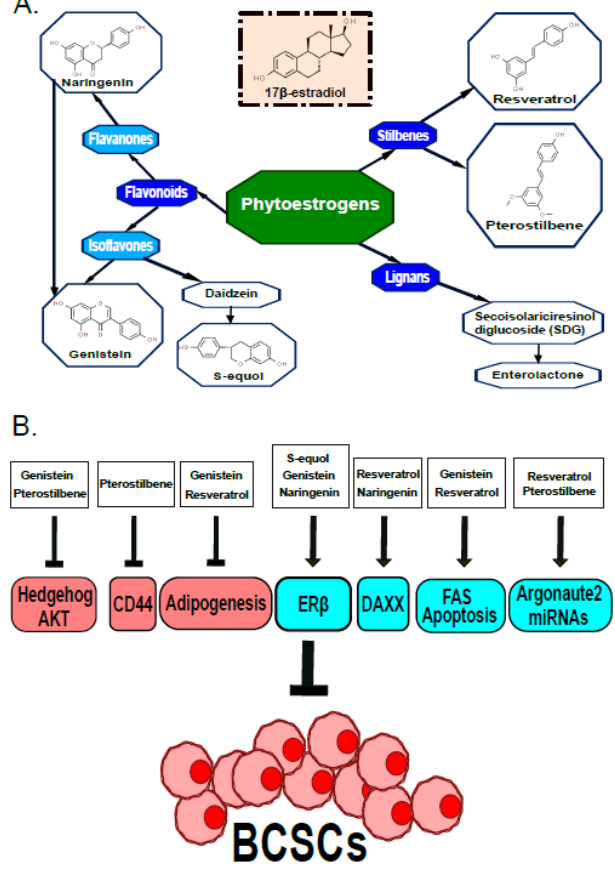
Figure 1. Structure and Function of Phytoestrogens on Breast Cancer Stem Cells. ( A ). Chemical structures of different classes of phytoestrogens compared to 17 β -estradiol. Colors highlight differ- ent subclasses of phytoestrogens. ( B ). Phytoestrogens either inhibit or activate different signaling pathways to suppress breast cancer stem cells (BSCS). Specifically, inhibition of hedgehog, CD44 or adipogenesis by genistein, pterostilbene or resveratrol reduces survival of BCSC. Activation of ER β , DAXX, FAS, argonaute2 or miRNAs by S-equol, genistein, naringenin, resveratrol or pterostilbene suppresses survival of BCSC. Red indicates inhibition of pathways. Blue indicates activation of path- ways.